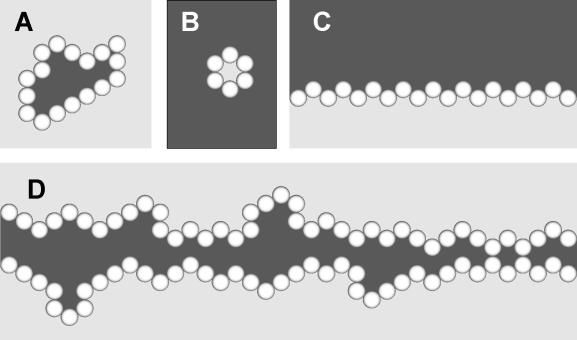
Examples of Analogue 1 Outcomes in Four Simulated EnvironmentsSpheres represent cells; black space represents free space or a simulated lumen space; a light shaded space represents matrix.(A) Stable cysts formed in simulated embedded culture.(B) A stable, inverted cyst formed in simulated suspension culture.(C) A stable monolayer formed in simulated surface culture.(D) A stable lumen formed in simulated overlay culture.